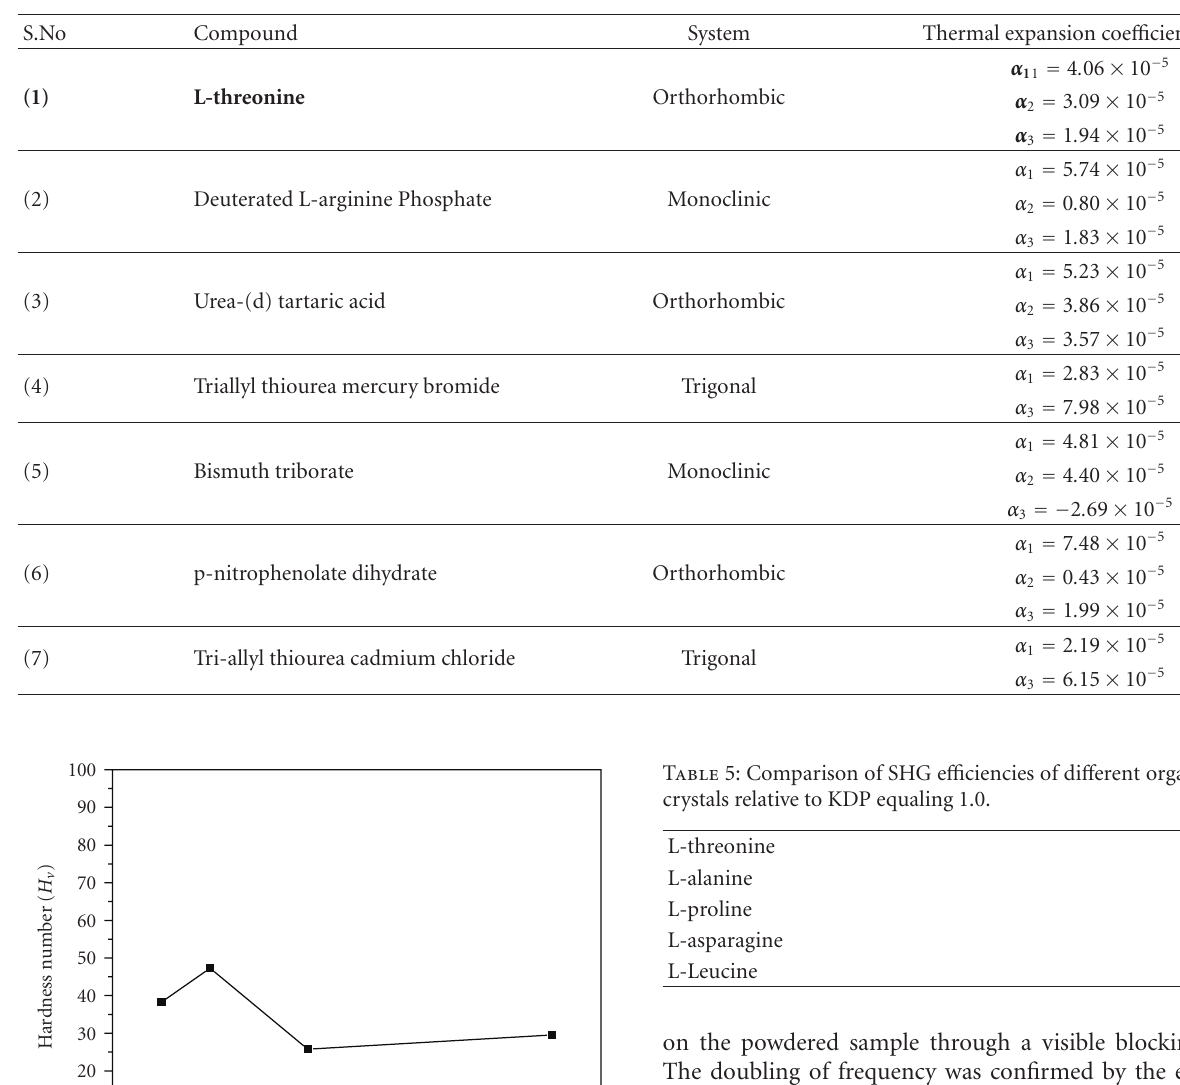
Table 4: Comparative data on thermal expansion coe ffi cient values of various novel NLO crystals.